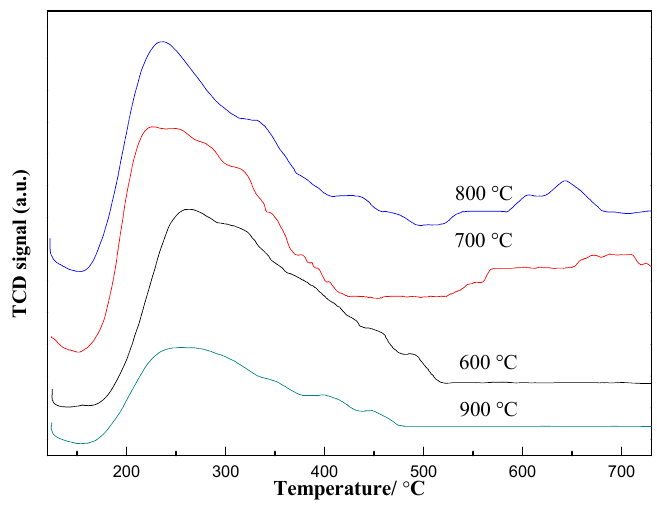
Figure 9. The NH 3 -TPD curves of Cr-Pt/WZ catalyst calcined at 600~800 ◦ C.